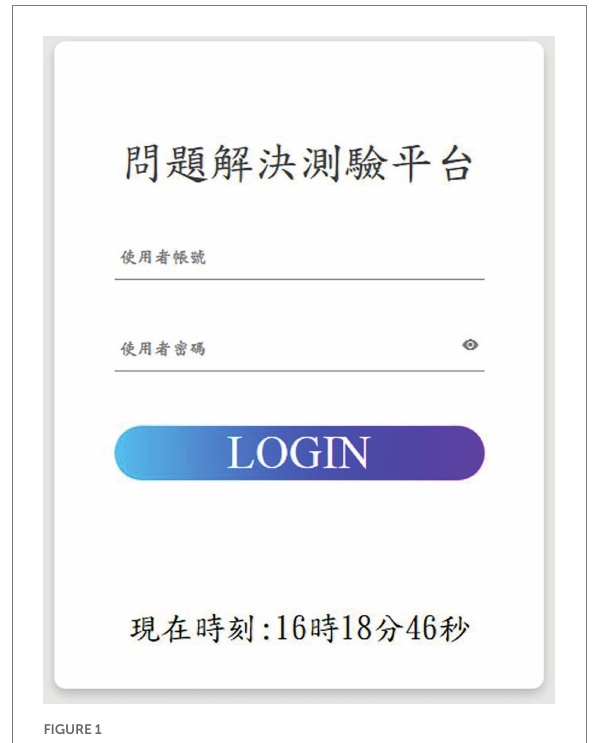
FIGURE 1 The login page of the interactive creativity task